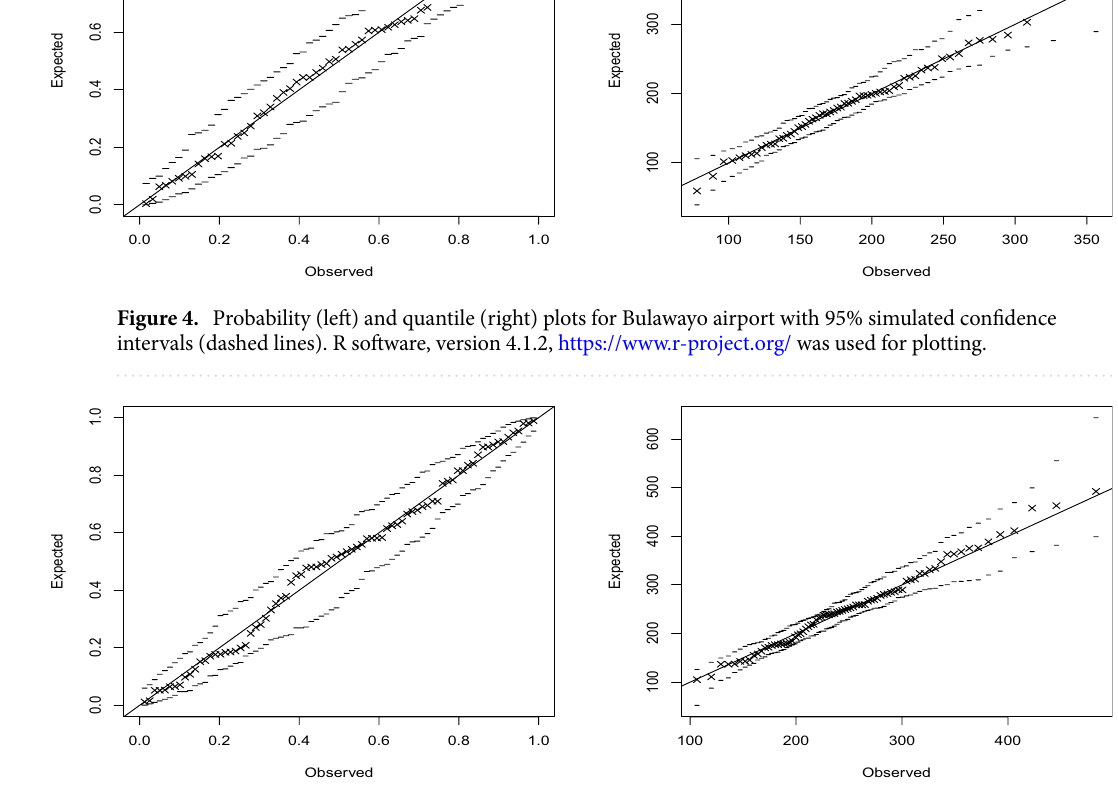
Figure 5. Probability (left) and quantile (right) plots for Harare airport with 95% simulated confidence intervals (dashed lines). R software, version 4.1.2, https:// www.r- proje ct. org/ was used for